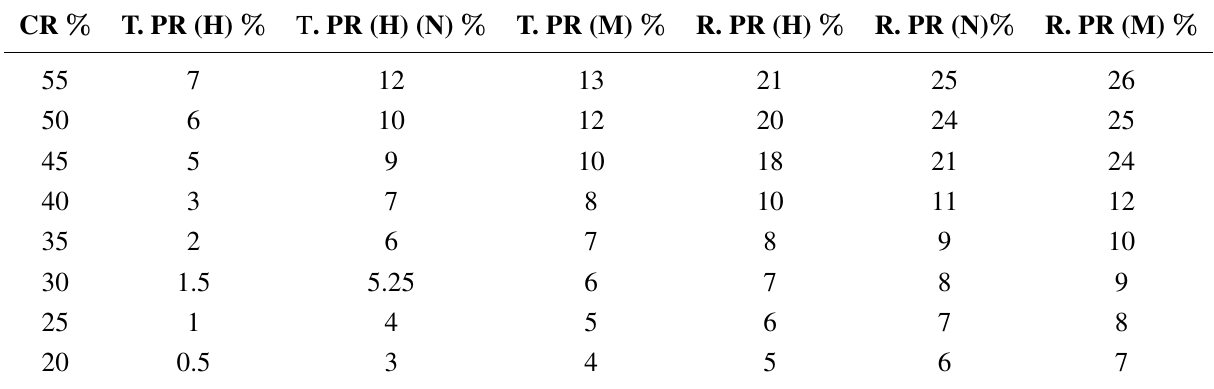
Table 12. Comparison on Power Reduction based on